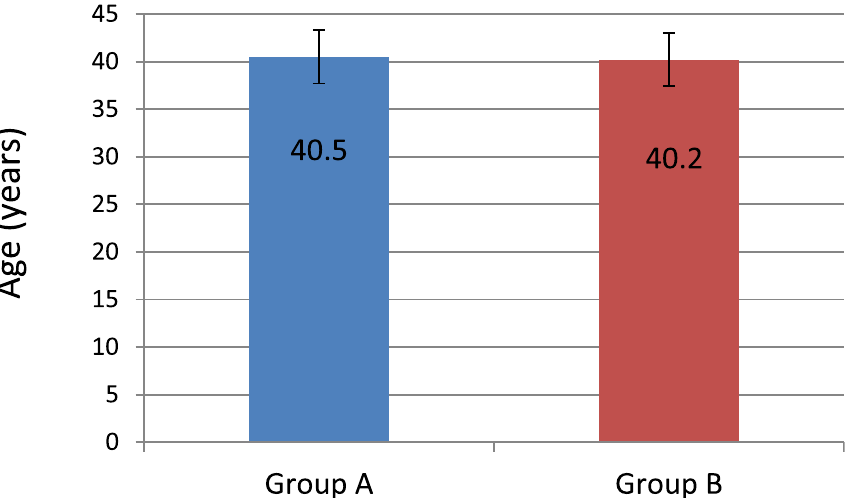
Fig. 3 Mean values of subjects’ age in the two